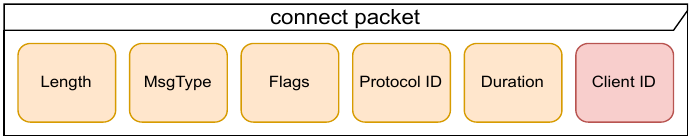
Figure 10. MQTT-SN connect packet format.